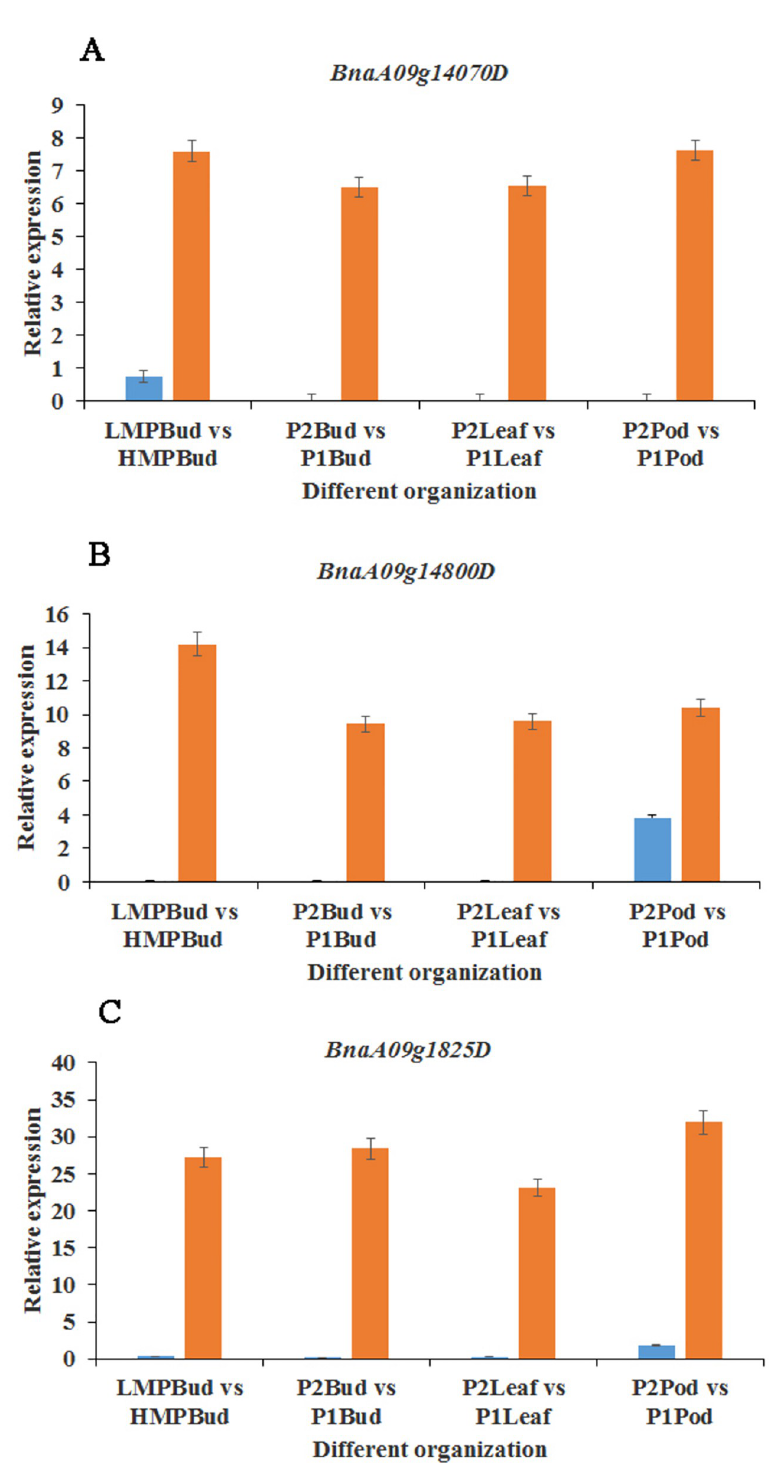
Fig 7. Analysis of the differential expression of candidate genes. A represents the relative differential expression of the candidate gene BnaA09g14070D in different tissues, B represents the relative differential expression of the candidate gene Bna09g14800D in different tissues, C represents the relative differential expression of the candidate gene BnaA09g18250D in different tissues. LMPBud: bud mixed pool with extremely low SD; HMPBud: bud mixed pool with extremely high SD, P1: No.935, P2: No.